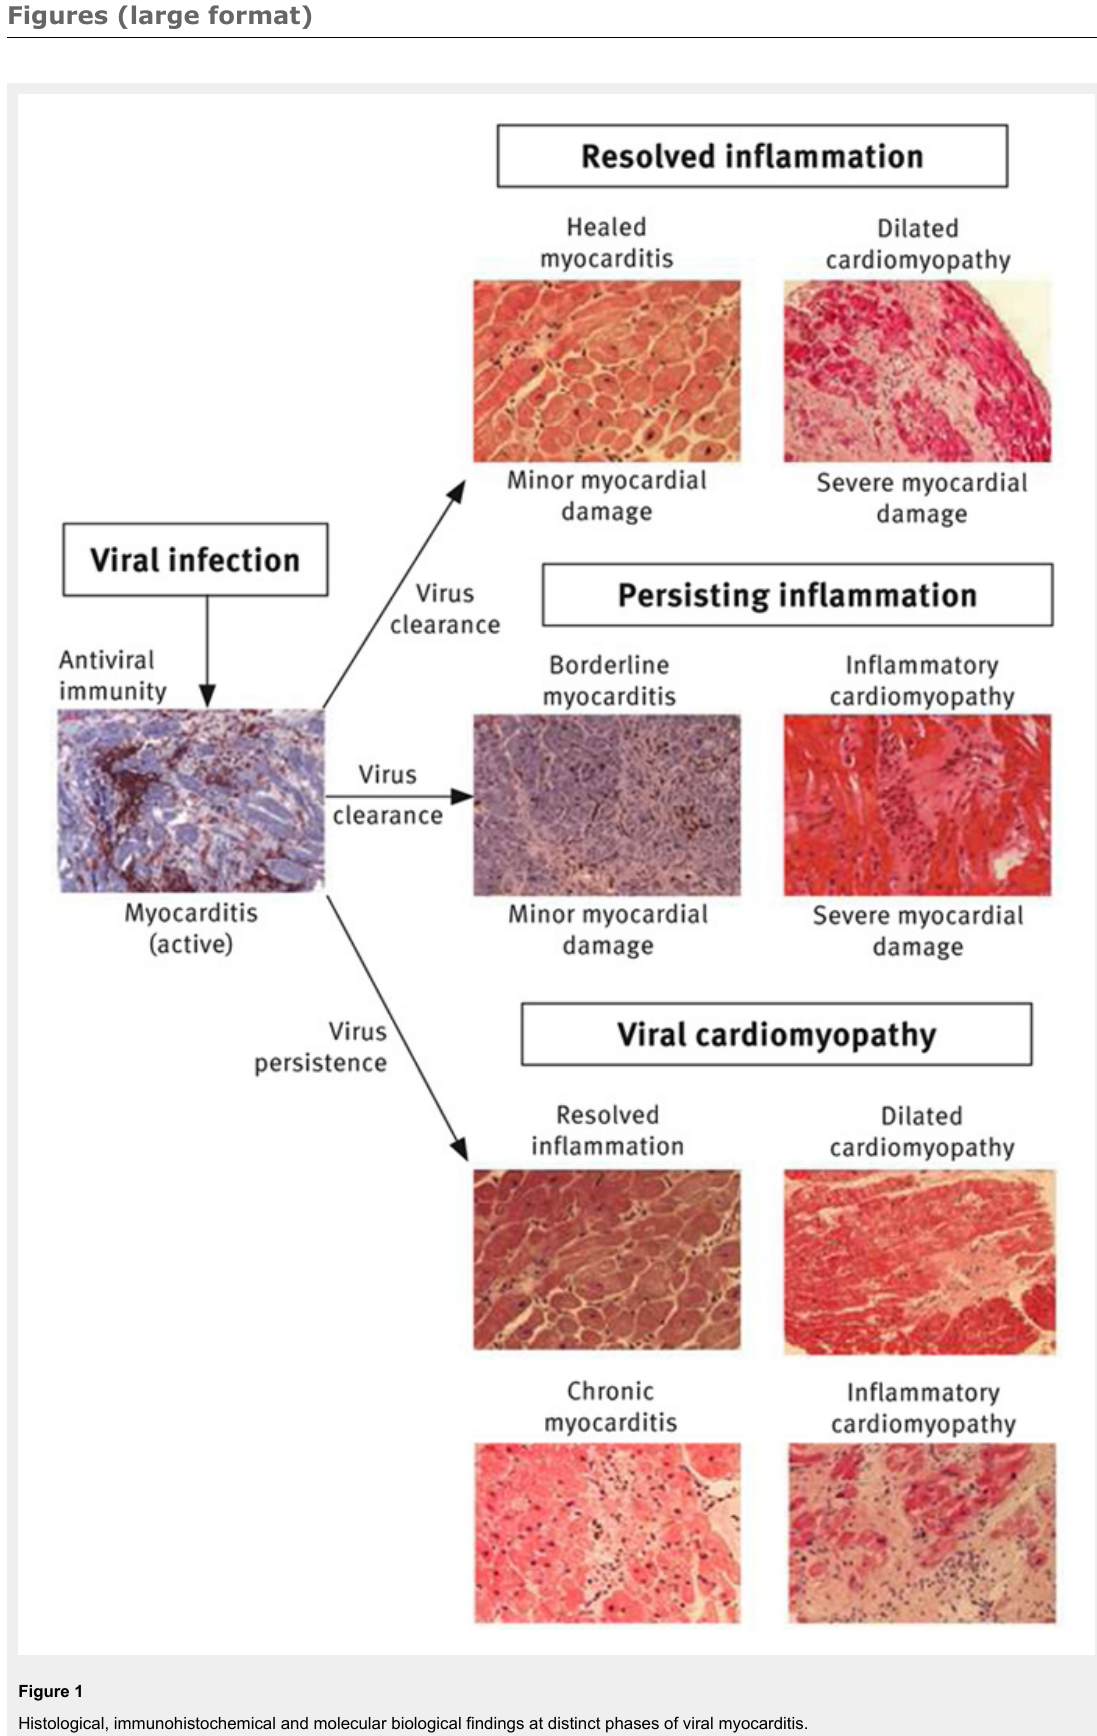
Figure 1 Histological, immunohistochemical and molecular biological findings at distinct phases of viral